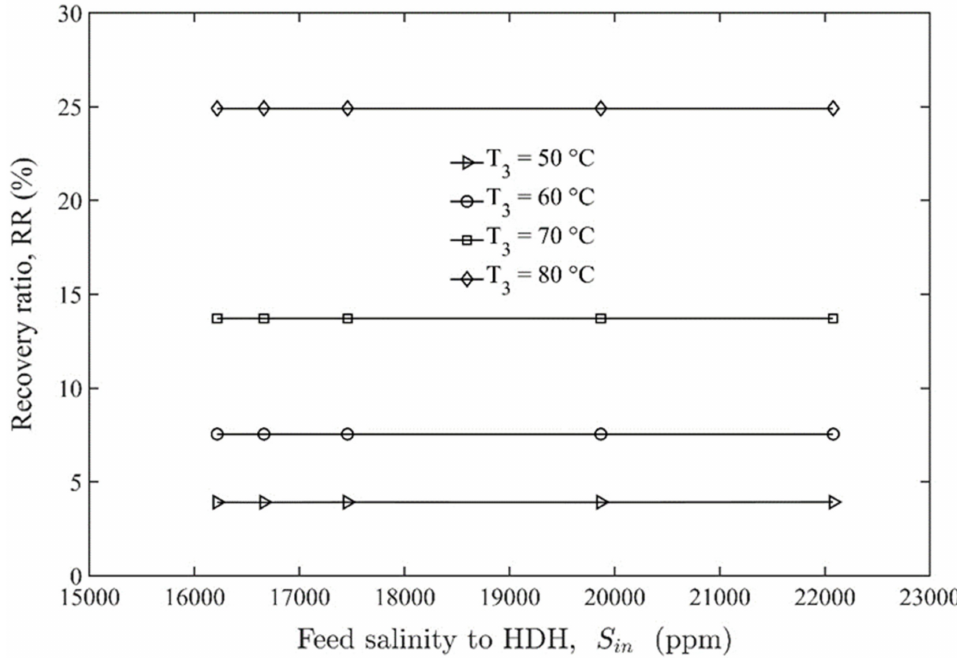
Figure 11. Recovery ratio from HDH unit at different humidifier inlet water